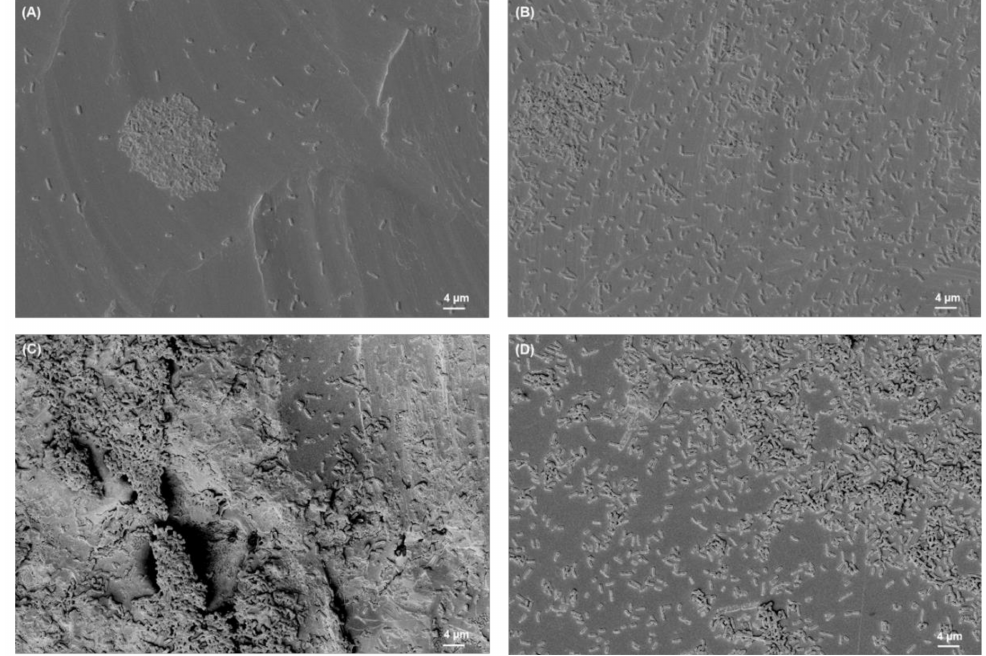
Figure 6. E. coli biofilm on ( A ) Ti grade 23, ( B ) Ti grade 2, ( C ) Ti grade 5, ( D ) Ti grade 5 polished. All images were recorded at high voltage of 5 kV, magnification = 1.18 KX with scale bars = 4 µ